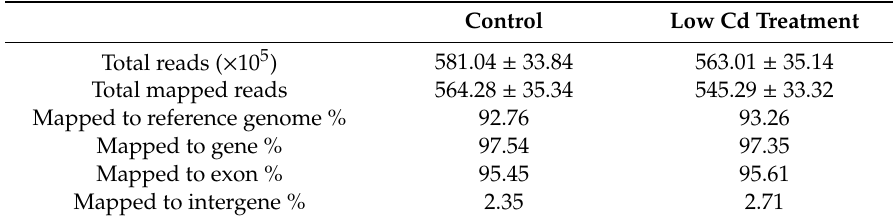
Table 1. Summary of RNA-sequencing data.